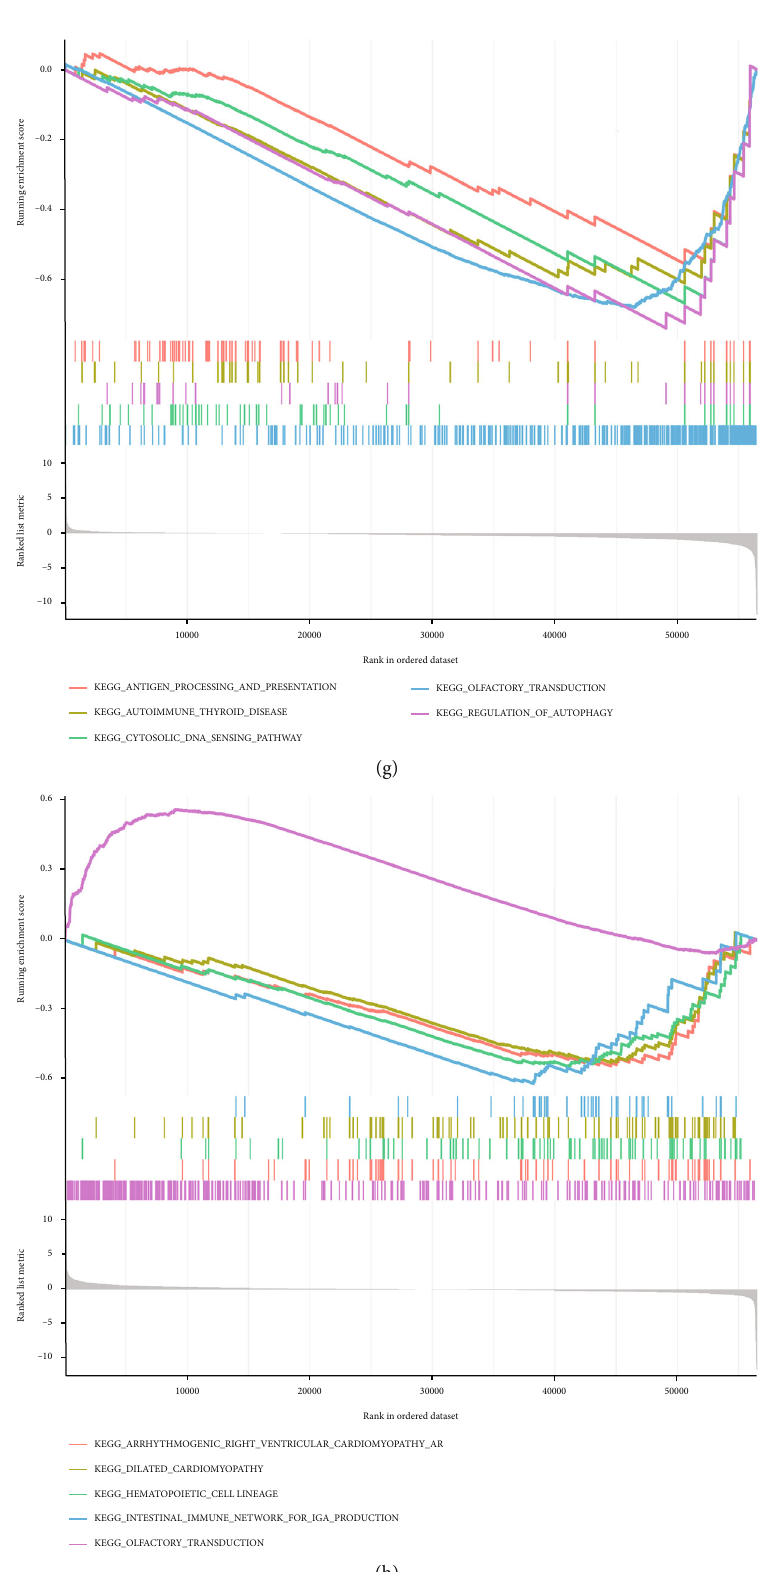
Figure 9: Single-gene GSEA enrichment analysis. (a) GO enrichment analysis in NFE2L2 gene STAD. (b) GO enrichment analysis in NLRP3 gene STAD. (c) GO enrichment analysis in SLC31A1 gene STAD. (d) GO enrichment in GCSH-based STAD set analysis. (e) KEGG enrichment analysis in NFE2L2 gene STAD. (f) KEGG enrichment analysis in NLRP3-based STAD. (g) SLC31A1 gene STAD in KEGG enrichment analysis. (h) GCSH-based STAD in KEGG enrichment